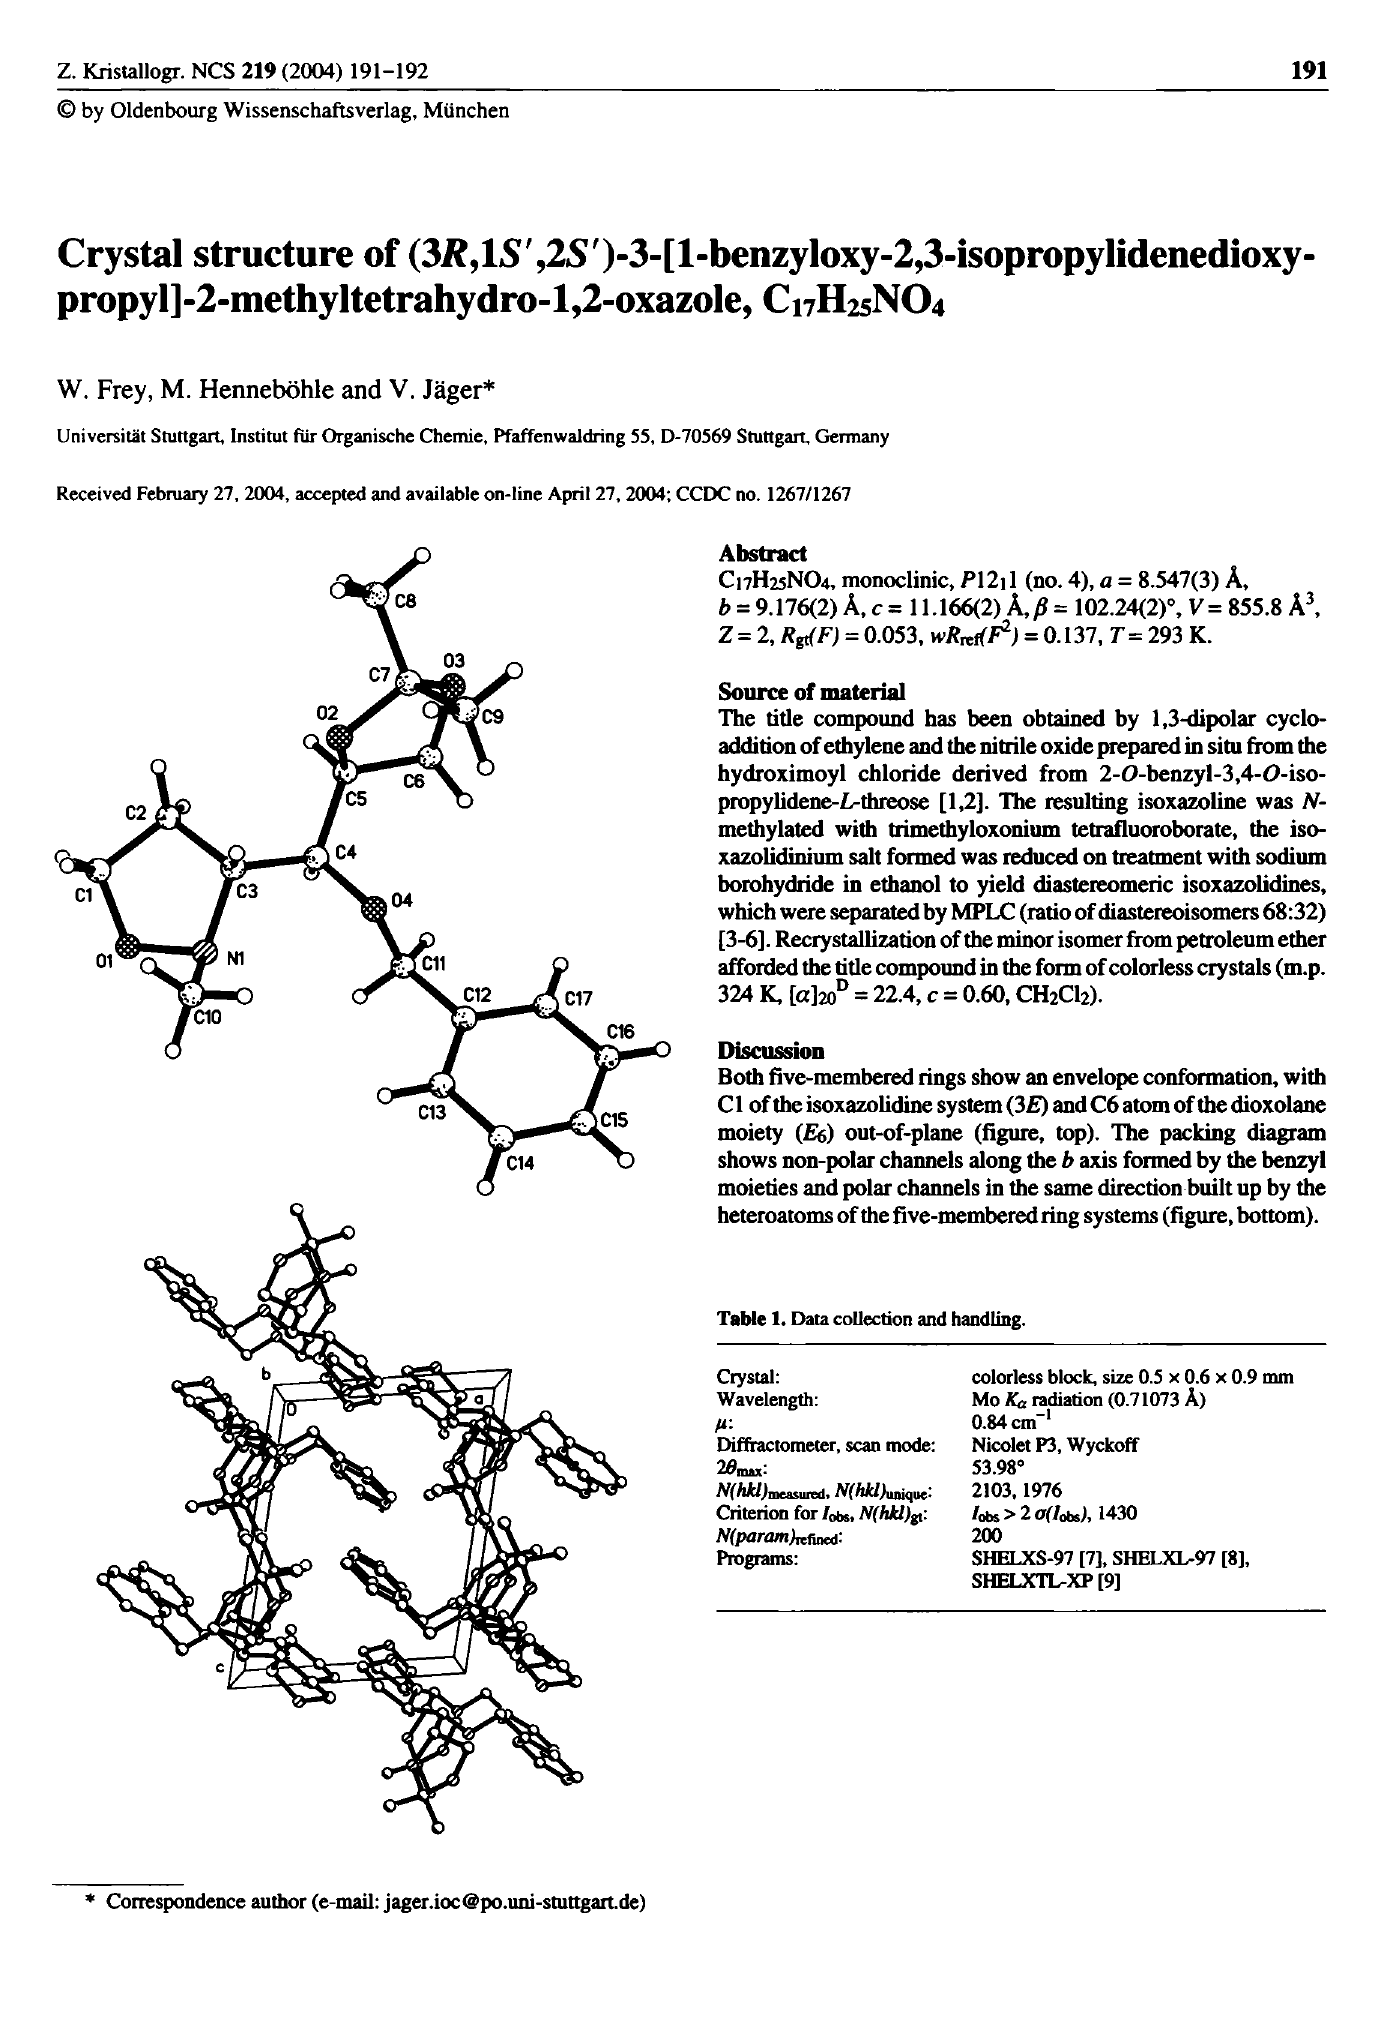
M- Diffractometer, scan mode: 26nux- APW)measured, WltOuniq«: Criterion for /obs, N(hkl)gc. N(paramhc